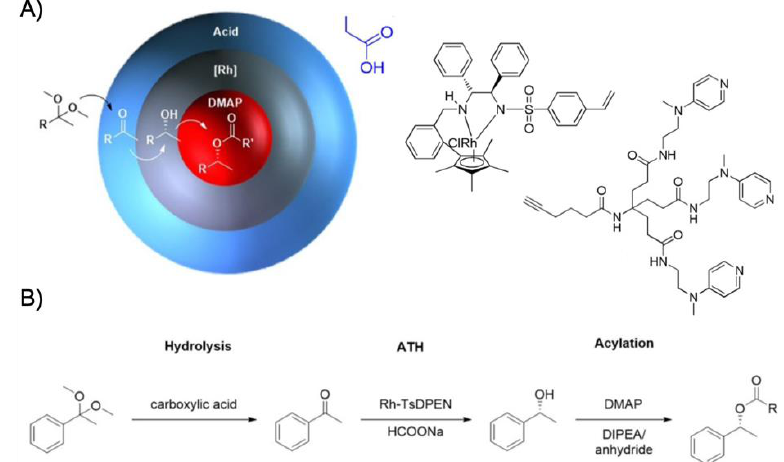
Figure 14. Core-shell-corona micelles with a cross-linked shell inheriting three incompatible catalysts. ( A ) Poly(2-oxazoline)-based core-shell-corona morphology with acid, base, and metal catalyst isolated in corona, core, and shell respectively. ( B ) Three-step reaction for hydrolysis-hydrogenation-acylation cascades of ketals to enantiomeric esters. Adapted and reproduced with permission of [133]. Copyright 2018 Wiley-VCH.